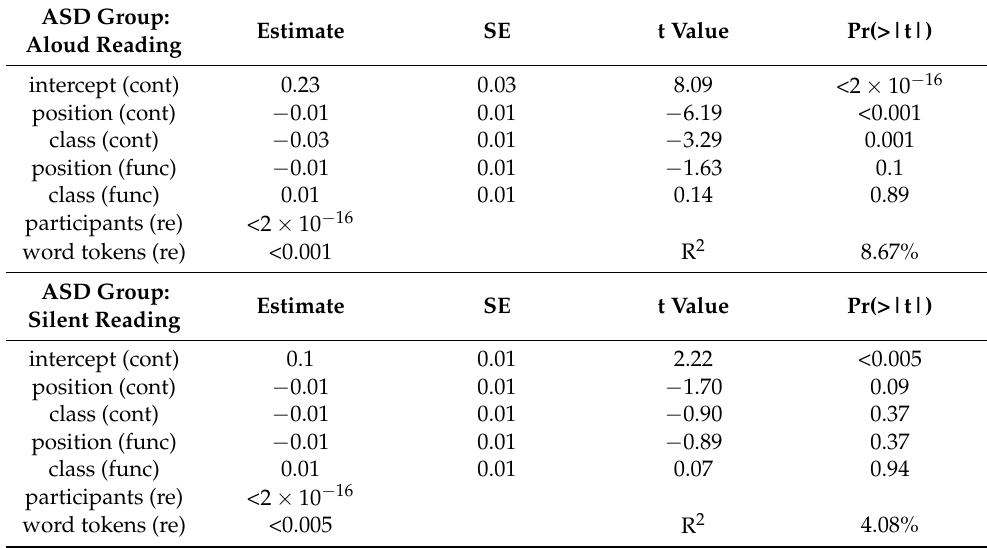
Table 8. GAM coefficients for models fitting tracking time on symbols as a function of symbol position in the word ( position ) in interaction with content vs. function words ( cont, func ) and grade level ( class ) for the two reading modalities. Participants in the ASD group and word tokens are added as random effects ( re ).